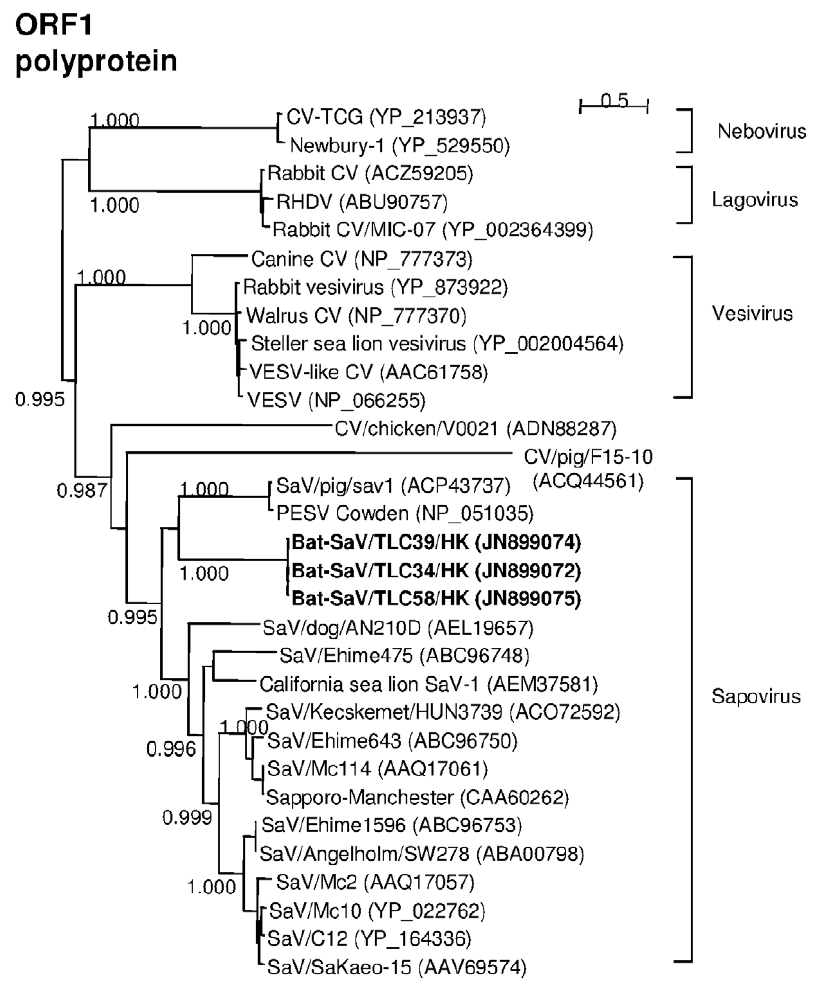
Figure 2. Unrooted maximum-likelihood tree based on full-length amino acid sequences of ORF1 precusor polyprotein. SH-like aLRT branch support values of greater than 0.70 are shown besides major branches. Scale bar indicates the number of inferred substitutions per site.